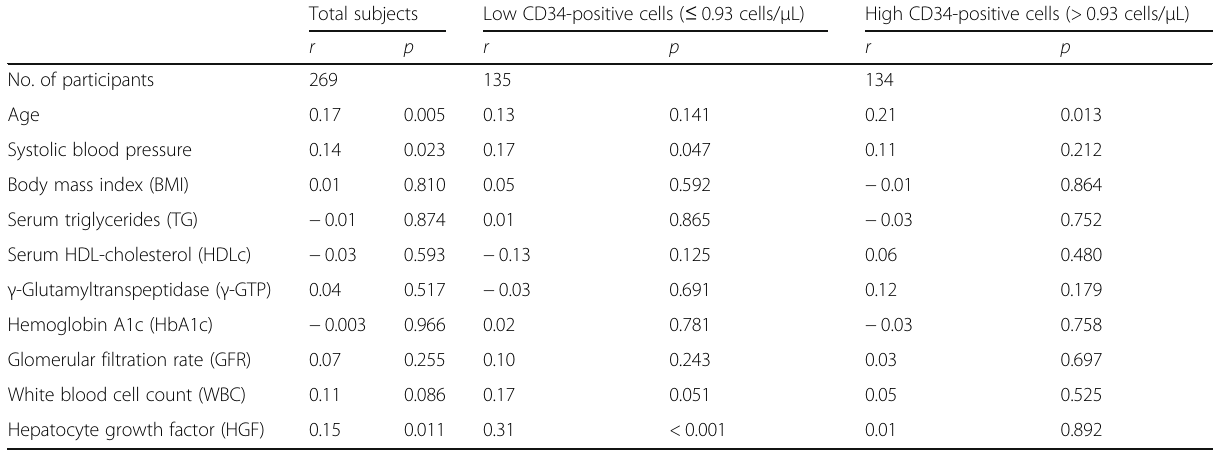
Table 2 Simple correlation analysis of carotid intima-media thickness (CIMT) and other variables